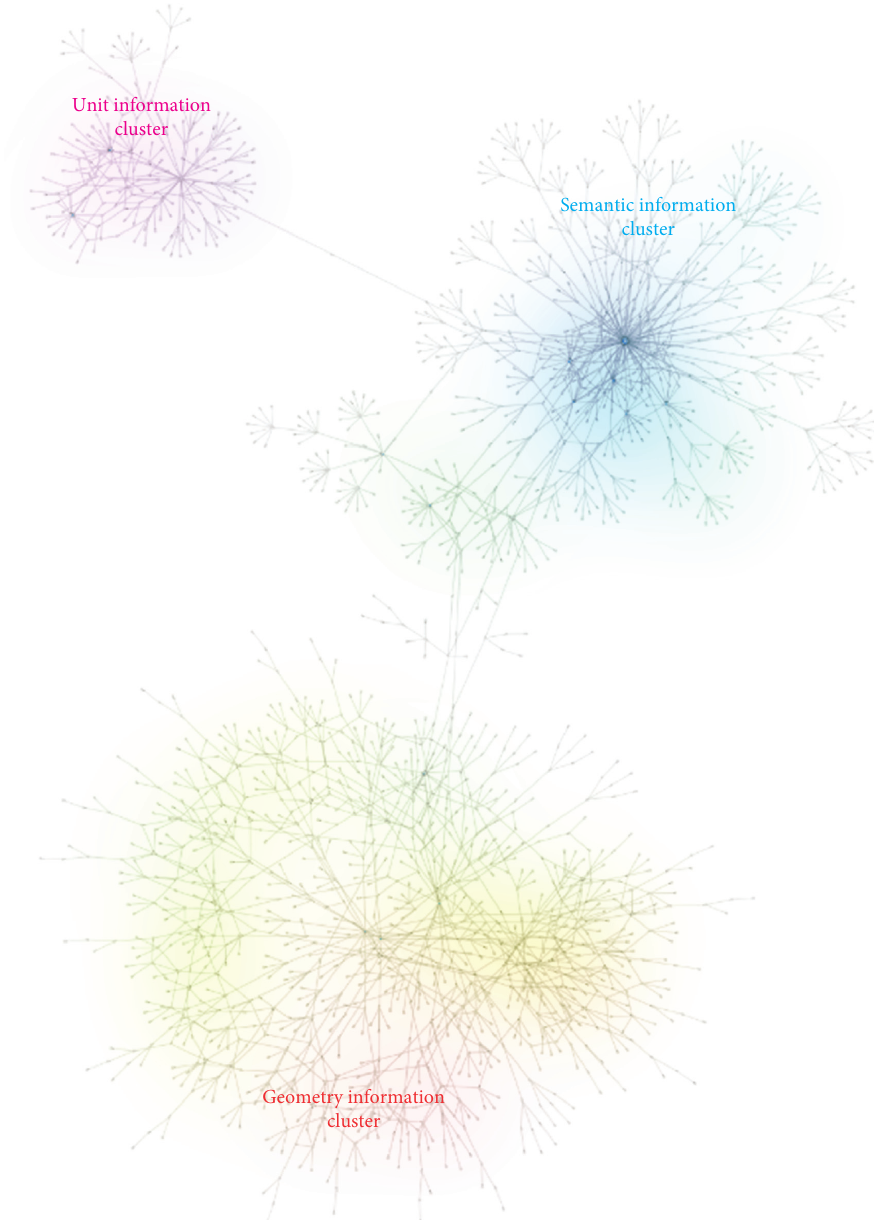
Figure 10: Graph representation of the IFC model of a single BIM